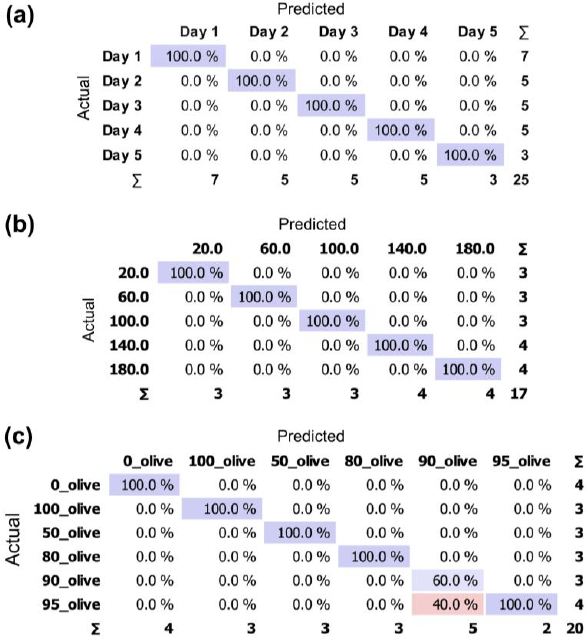
Figure 6. Confusion matrices for Support Vector Machine SVM classification of ( a ) poultry meat based